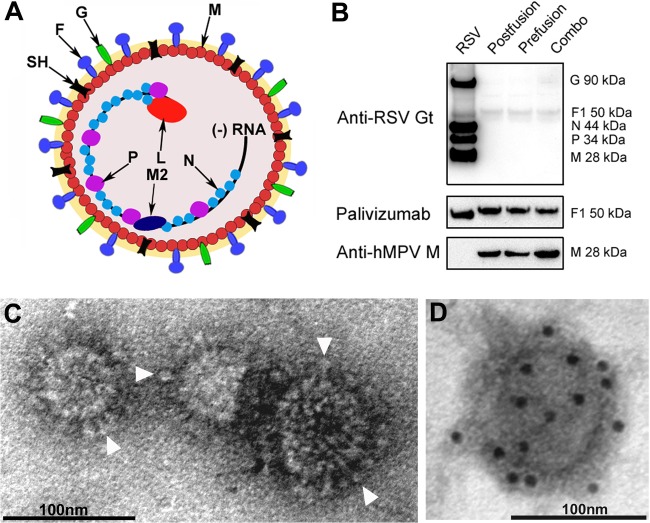
Structure and morphology of RSV VLPs using recombinant RSV F and hMPV M. (A) Drawing of RSV viral particles. F, G, SH, M, M2, P, N, and L proteins and genomic negative-sense RNA are indicated. (B) Western blot analysis of RSV VLPs using different antibodies such as goat anti-RSV (Anti-RSV Gt), palivizumab, and anti-hMPV M. The Western blotting experiment includes a purified RSV control. (C) Purified RSV VLPs were negatively stained and examined by electron microscopy. The micrograph shows spherical and irregular particles (90 to 100 nm) decorated with surface projections or “spikes” (arrowheads) resembling the morphology of RSV F. (D) Electron micrograph of immunogold-labeled RSV VLPs probed with the humanized monoclonal antibody palivizumab and developed with a goat anti-human antibody coupled to gold spheres (10 nm). The detection of gold spheres demonstrates that F is decorating the surface of the VLPs.